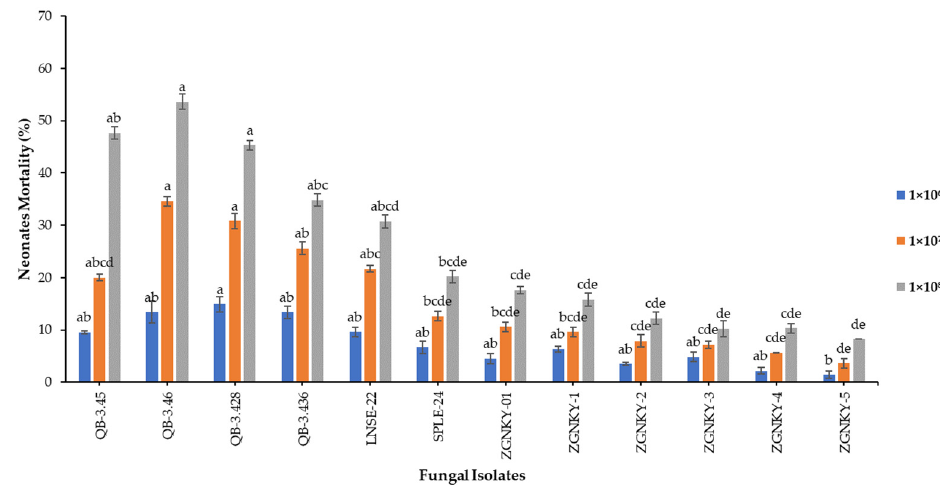
Figure 2. Mortality of neonatal larvae of FAW infected with B. bassiana isolates at the egg stage. Means followed by the same letters of alphabets are not significantly different according to Tukey’s test at p < 0.05.